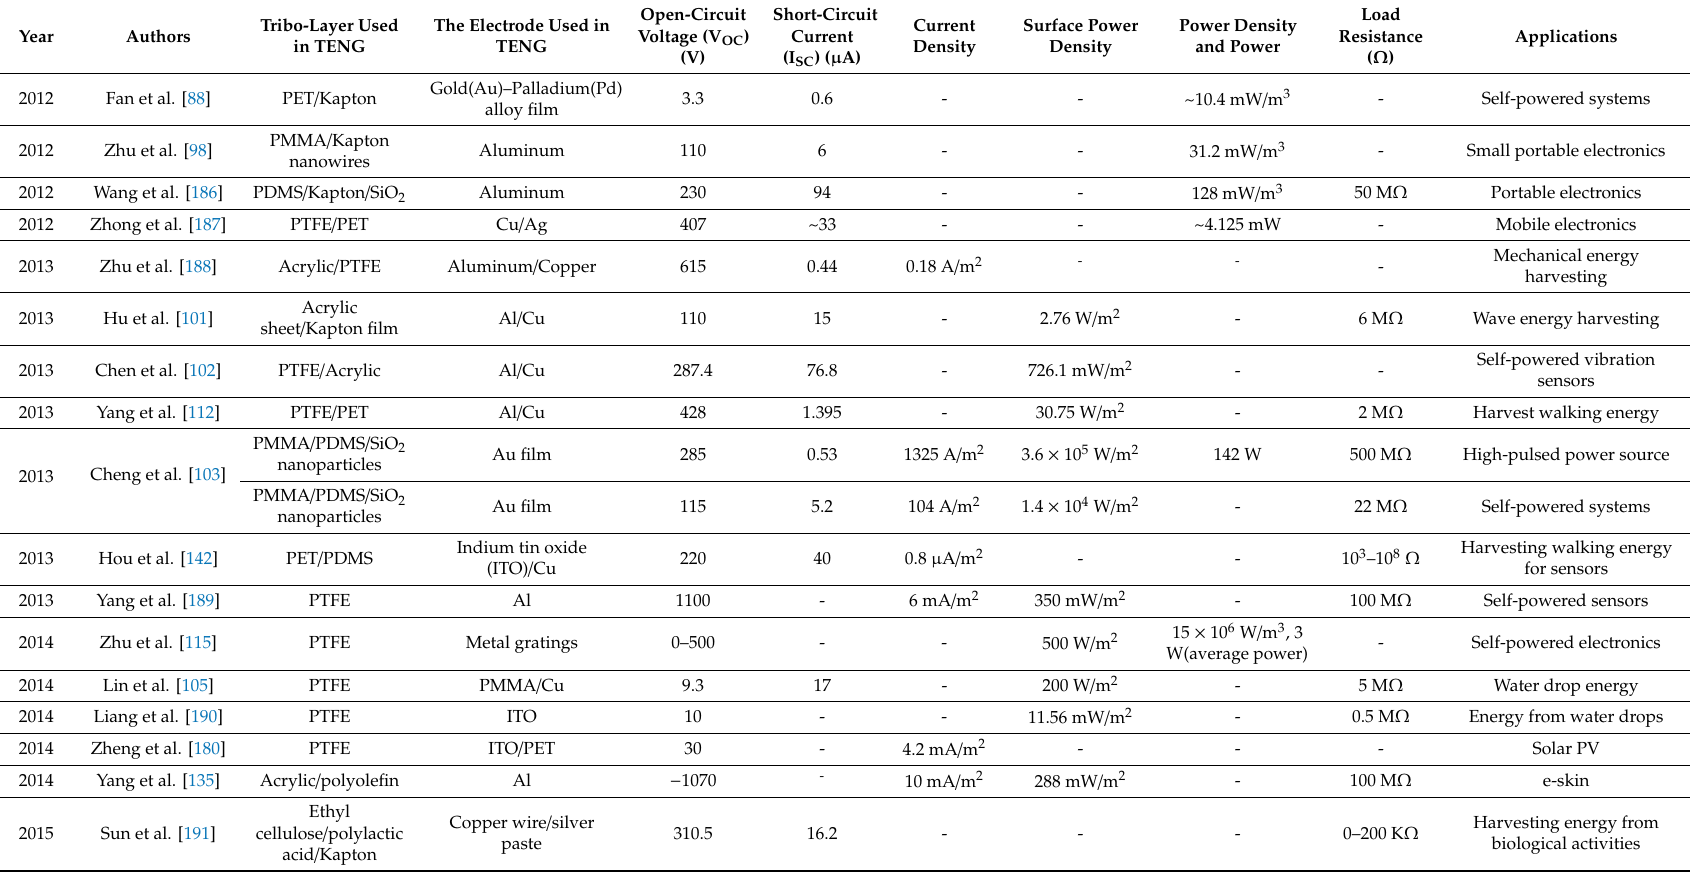
Table 5. Summary of experimental studies on di ff erent triboelectric nanogenerators